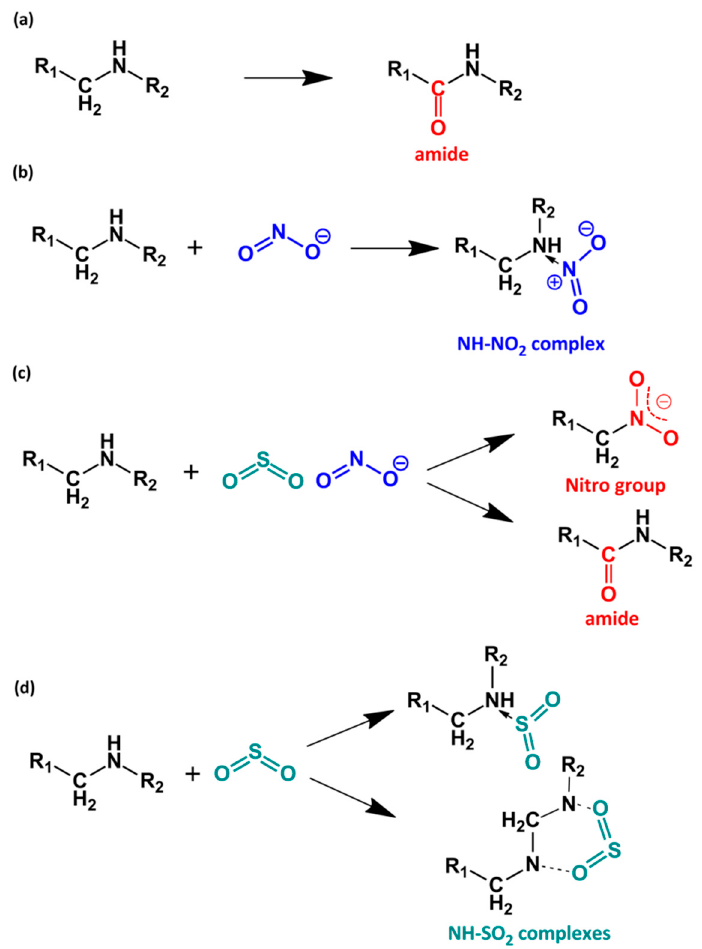
Figure 9. Proposed mechanisms for the formation of ( a ) amide with O 2 , ( b ) NH–NO 2 complex, ( c ) nitro groups and amide with acidic gases, and ( d ) NH–SO 2 complex with acidic gases.